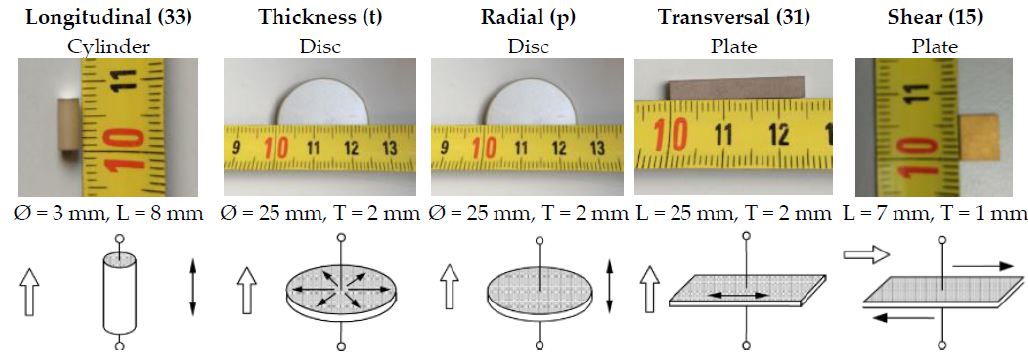
Figure 2. PIC255 ceramics used for obtaining piezoelectric coefficients following DIN EN 50324-02 standard. The hollow and solid arrows indicate the polarization direction and the displacement direction, respectively.